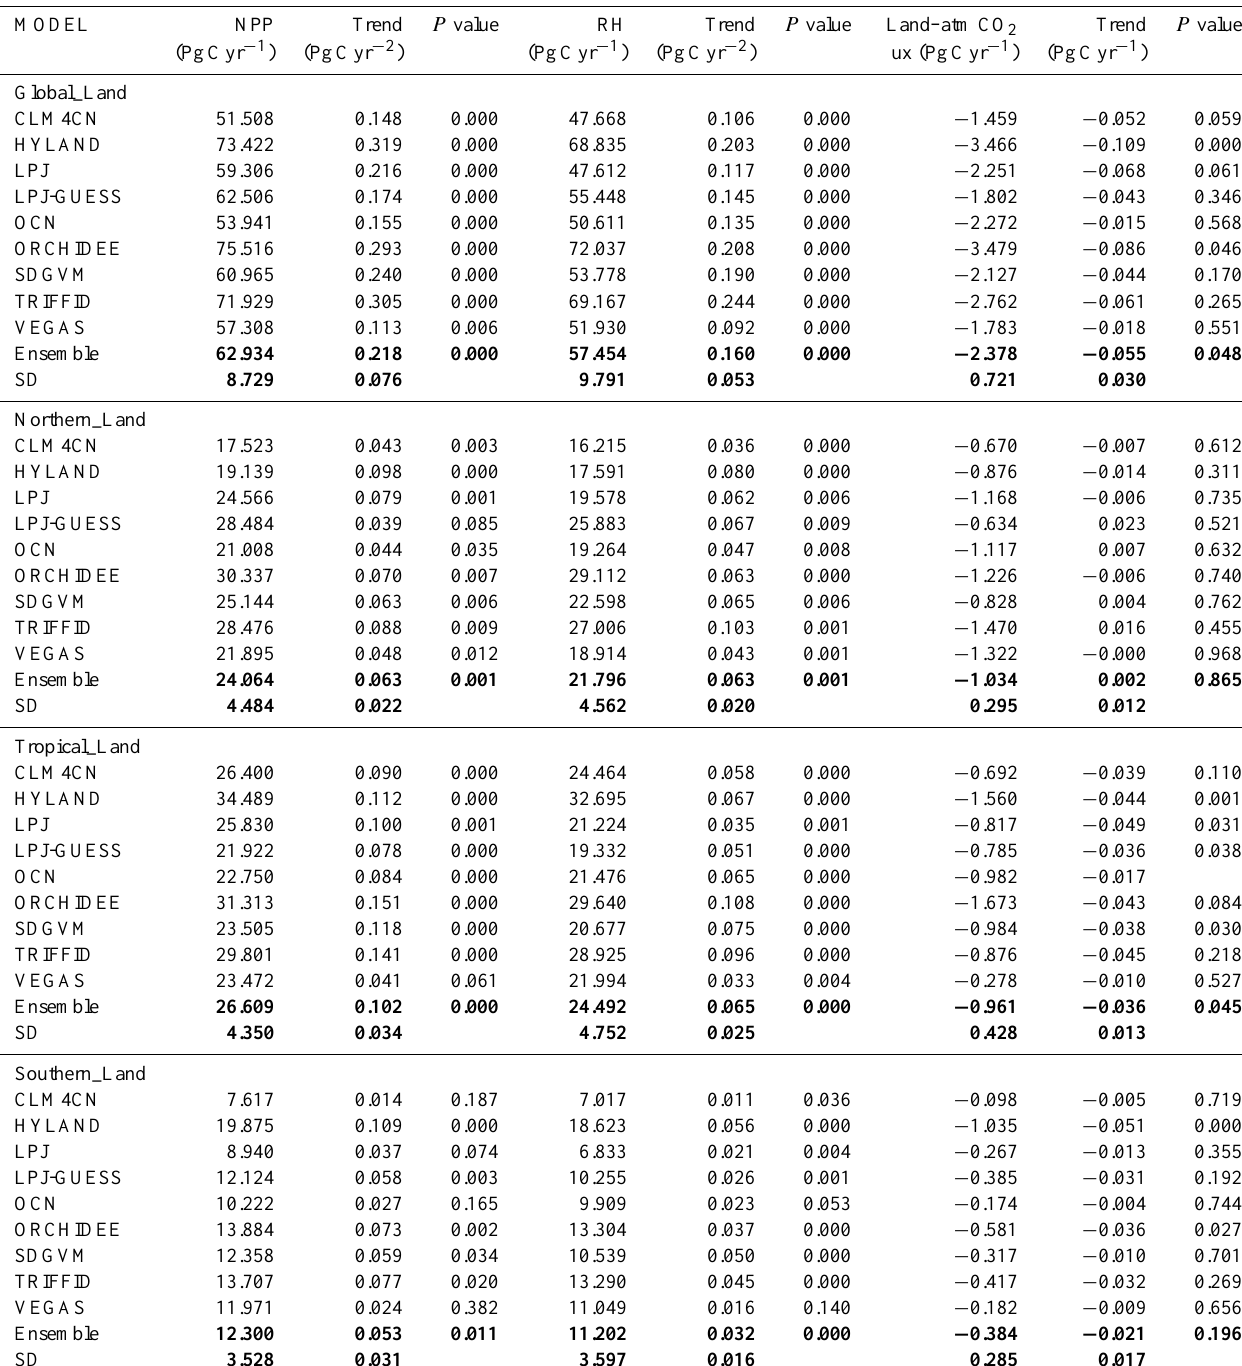
Table 3. Mean and trends in NPP, RH, and land–atmosphere flux as simulated by individual DGVMs and the ensemble mean.